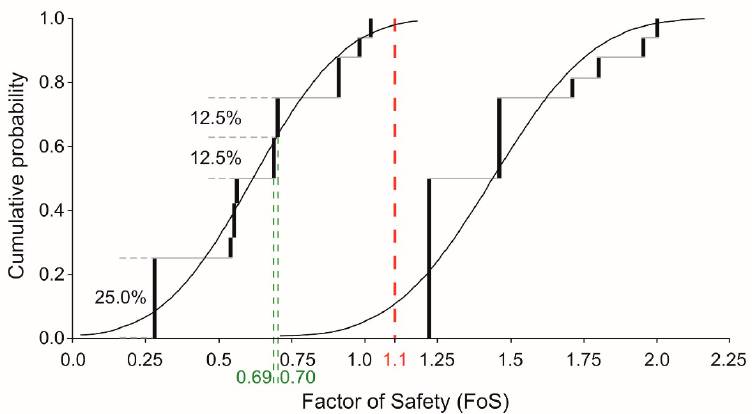
Figure 13. Graph of the lower and upper bounds of cumulative probability of factor of safety approximated by normal distribution